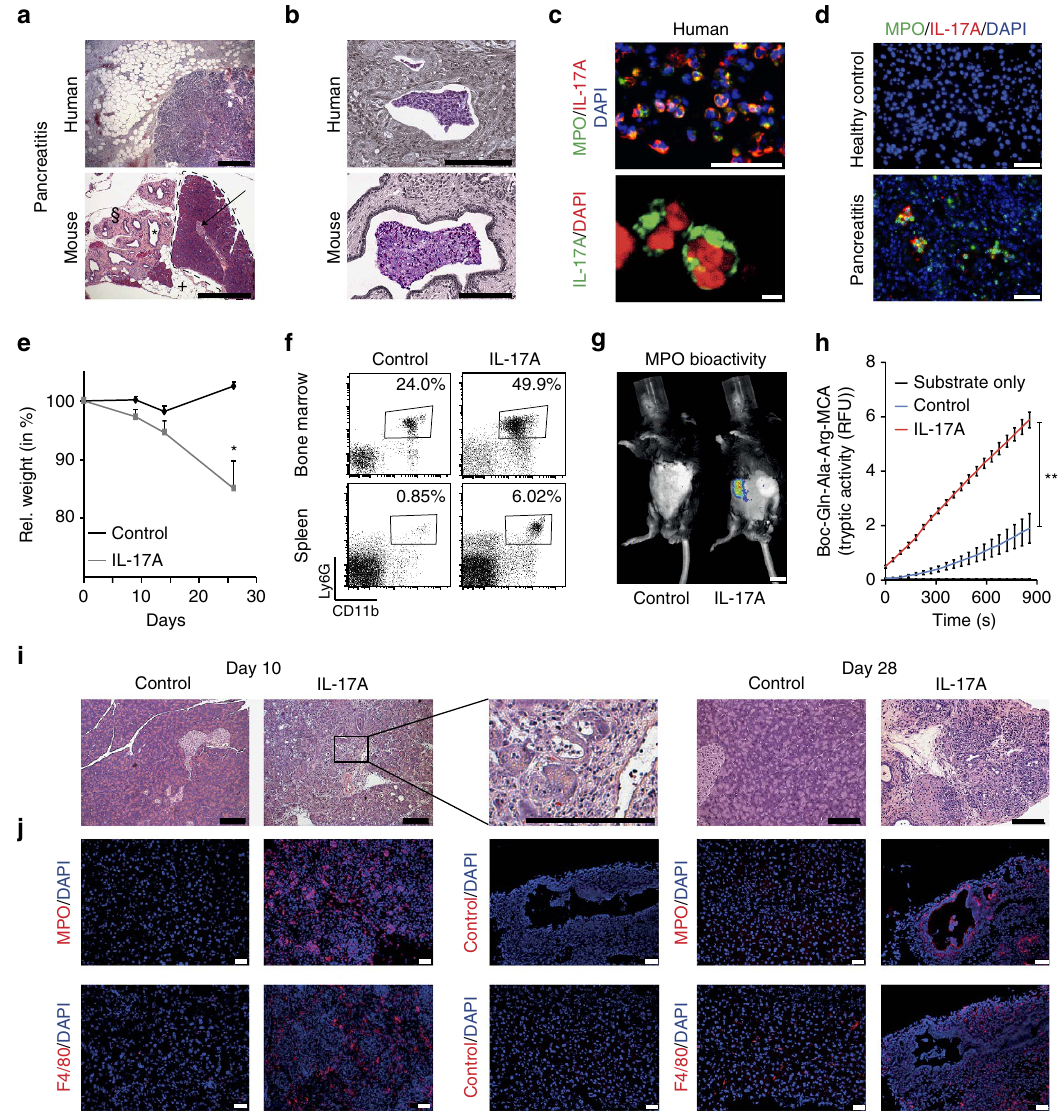
expression of this chemokine (Supplementary Fig. 4D).